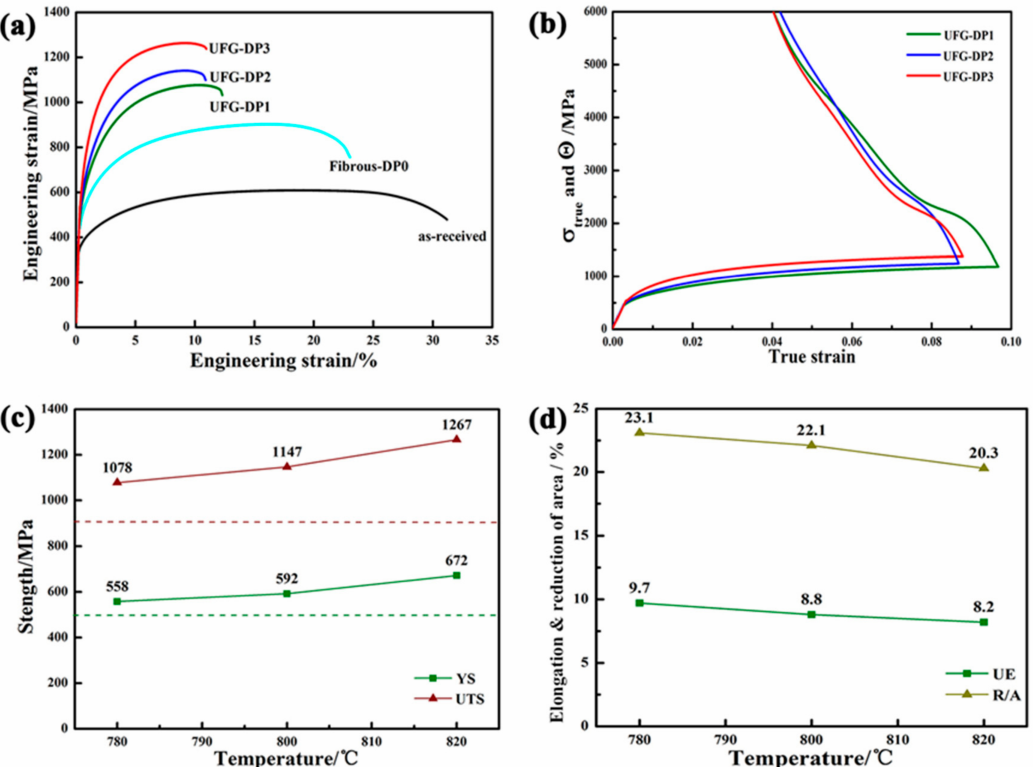
Figure 7. ( a ) Uniaxial tensile engineering strain–stress curves; ( b ) True stress ( σ true ) and strain hardening ( Θ ) curves from tensile tests. UFG-DP1, 2 and 3 respectively represent the samples after the final intercritical annealing at 780, 800 and 820 ◦ C for 1.5 min; ( c ) Yield strength (YS) and ultimate tensile strength (UTS) at different intercritical temperature. The two dashed lines represent the YS and the UTS of the fibrous DP steels respectively; ( d ) Uniform elongation (UE) and reduction of area (R/A) after annealing at different intercritical